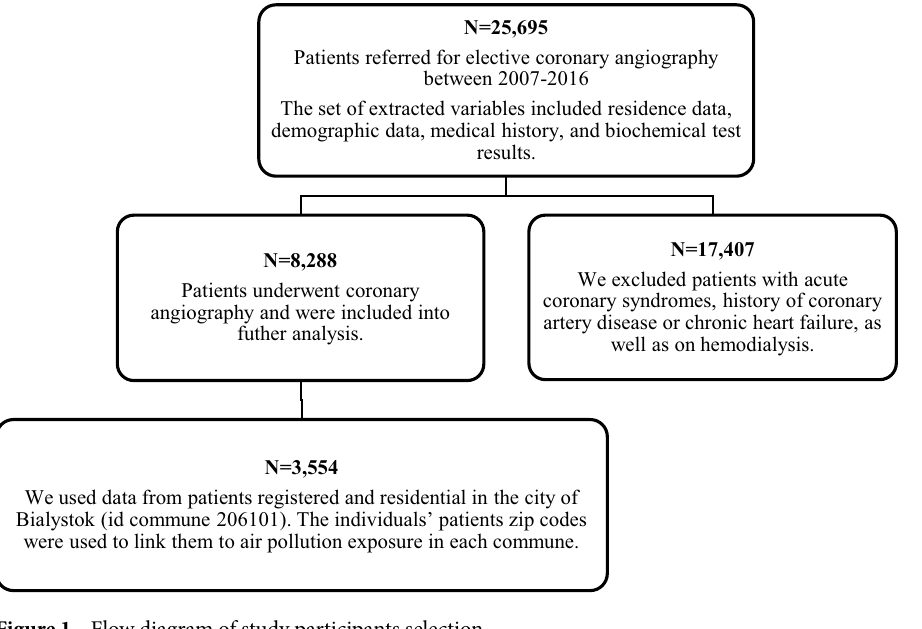
Figure 1. Flow diagram of study participants